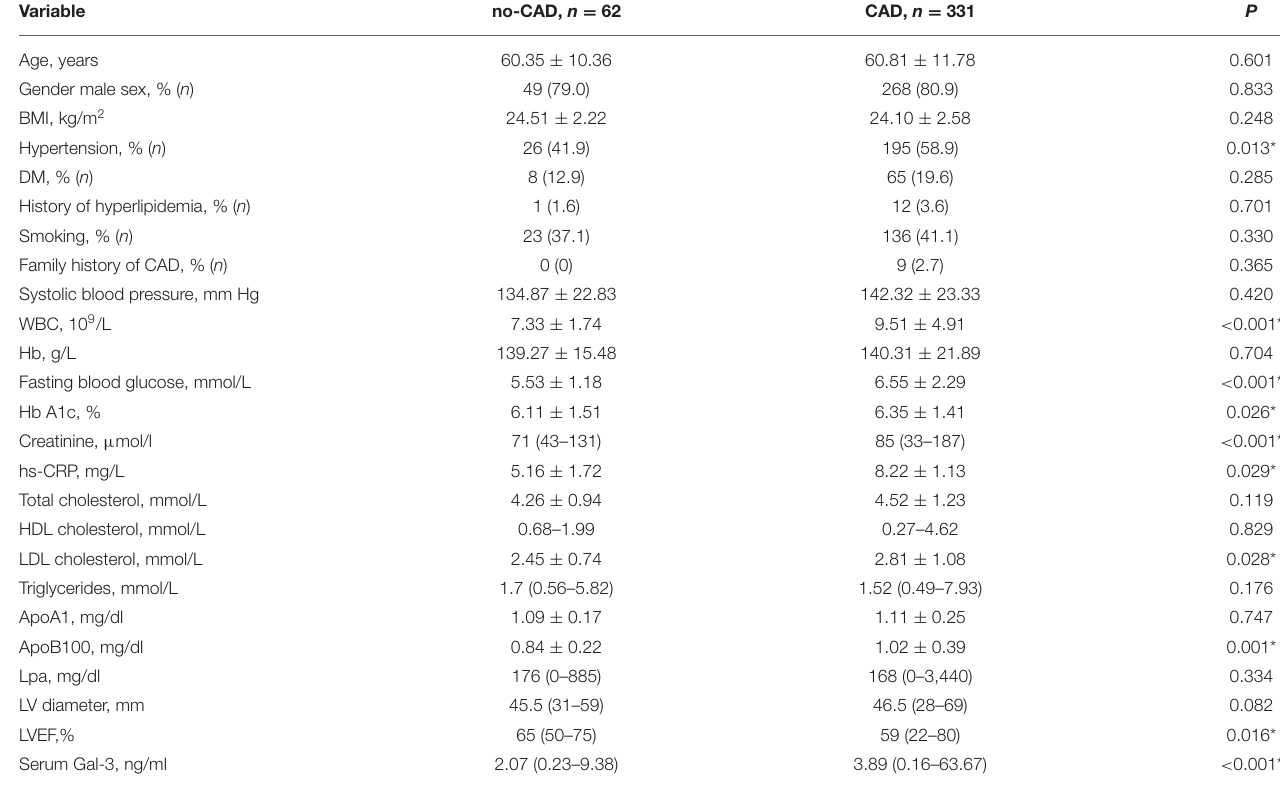
TABLE 1 | The baseline clinical and biochemical characteristics of the study with CAD or no-CAD. Variable